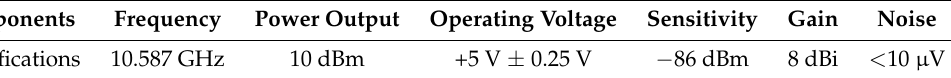
Figure 6. Doppler radar Motion Detector Unit (MDU1100T). Table 1. Main parameters for MDU1100T.